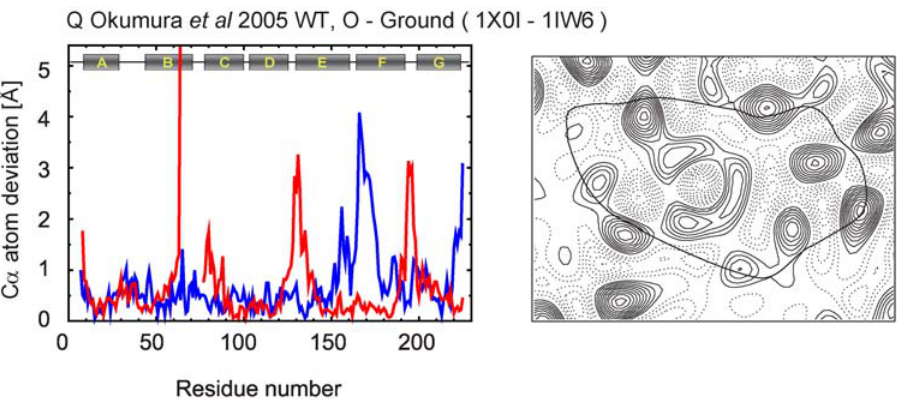
Figure 9. C a atom deviation plots and difference maps between intermediate and ground states calculated at 7 A˚ (continued).